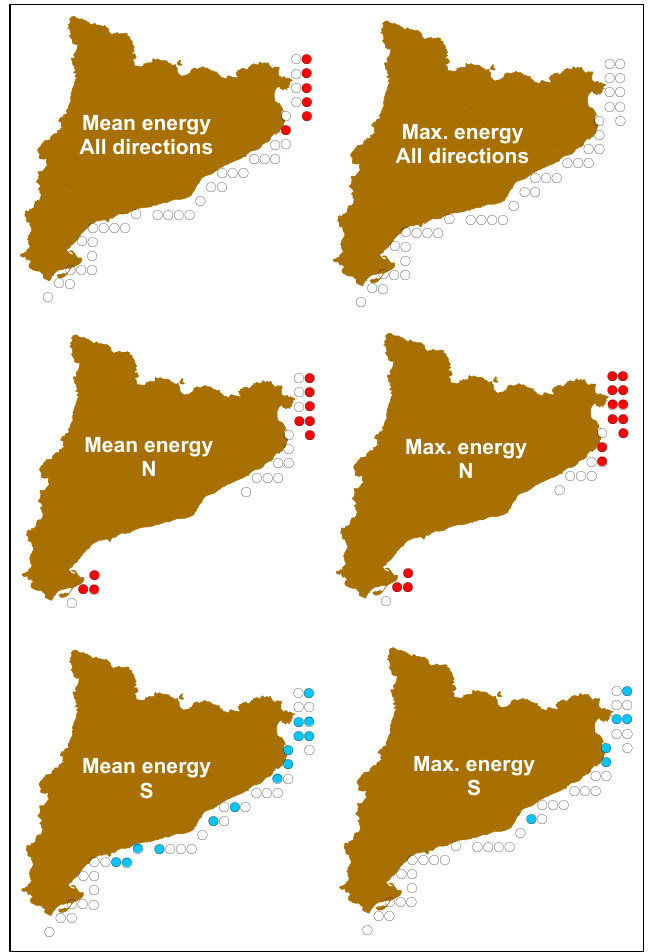
Fig. 7. Trend detection of E s for some directions. Red: negative trend. Blank: no significant trend. Blue: positive trend (adapted from Casas-Prat and Sierra,